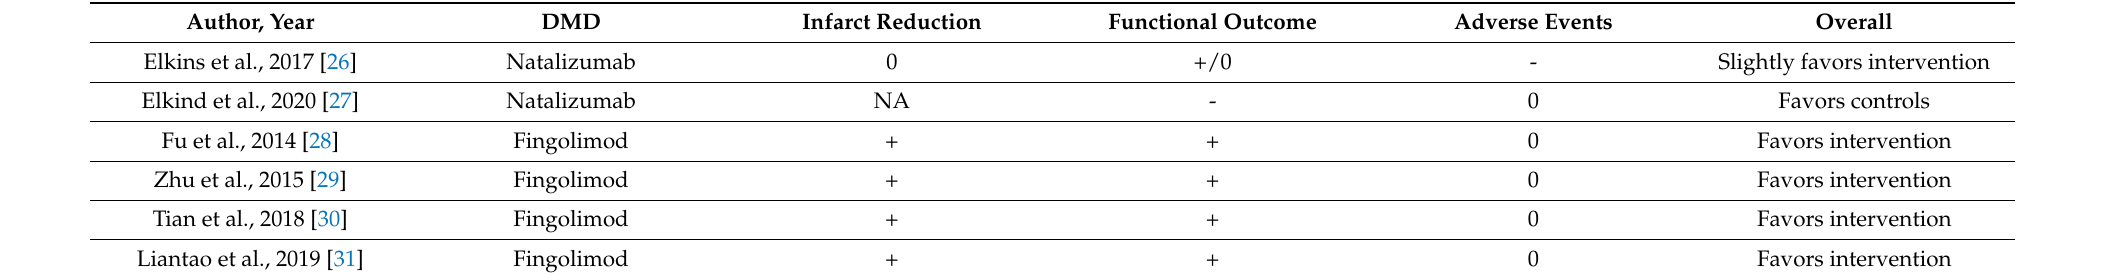
Table 2. Brief Summary of Human Studies’ Results on the Use of MS DMDs in Ischemic Stroke